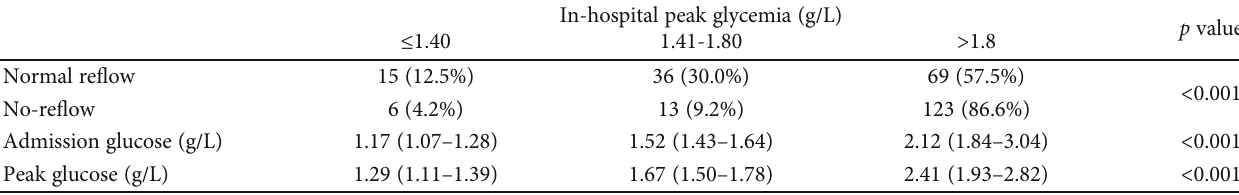
Table 3: In-hospital peak glycemia and the occurrence of no-re fl ow.